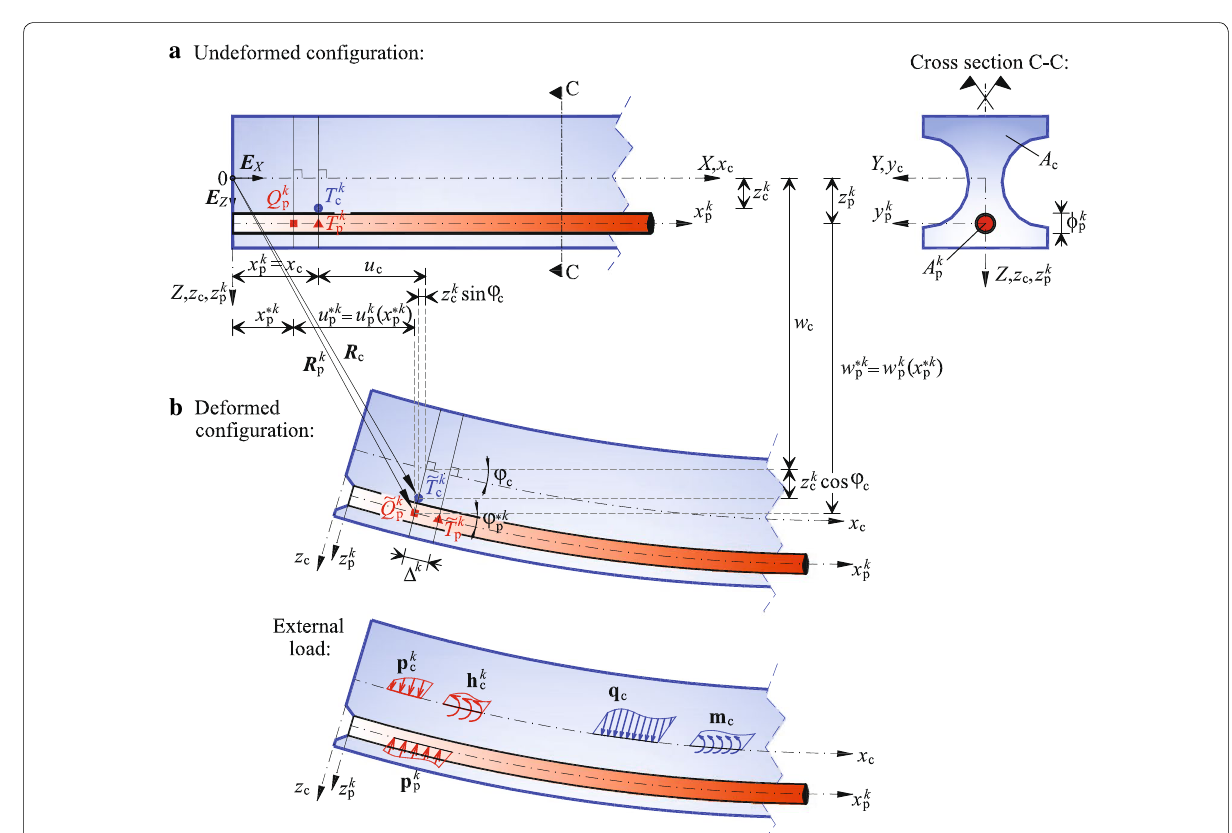
Fig. 2 Undeformed (reference) and deformed (current) configuration of prestressed concrete